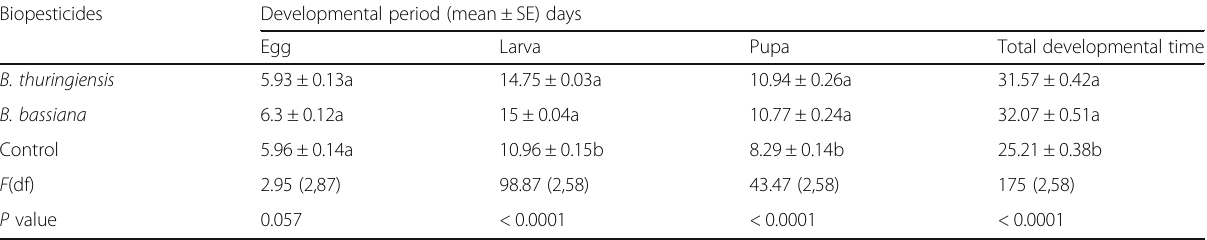
Table 2 Development of T. absoluta treated as second instar larvae by LC 50 values of B. thuringiensis or B. bassiana Biopesticides